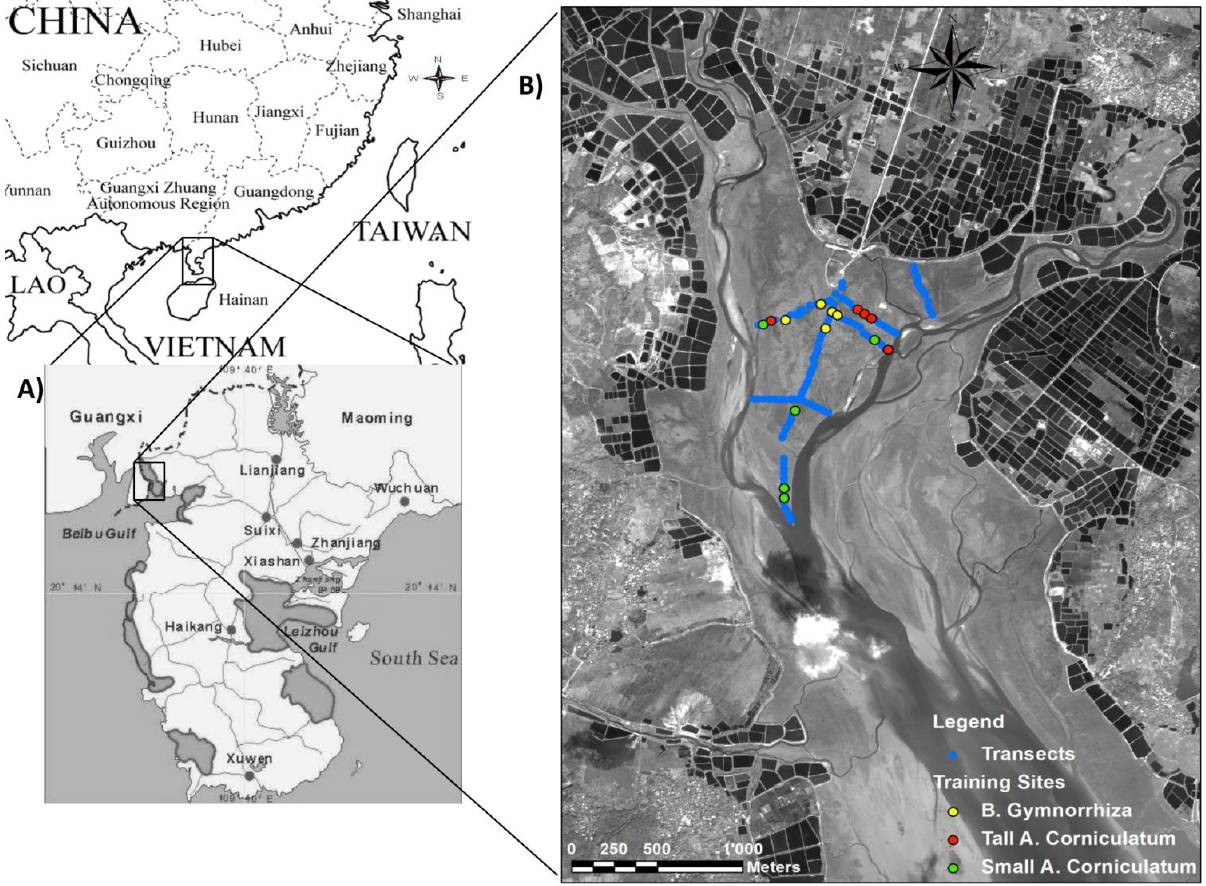
Fig. 1. (A) Mangrove areas found in Leizhou Peninsula of southern China, and (B) pansharpened multispectral GeoEye-1 satellite (2009) imagery showing Gaoqiao mangrove cover facing the Gulf of Tonkin. The ground inventory has been carried out in transects (blue points) running perpendicular to the coast/creek line. Training sites used for the supervised classification of the three mangroves classes are indicated in yellow, red and green